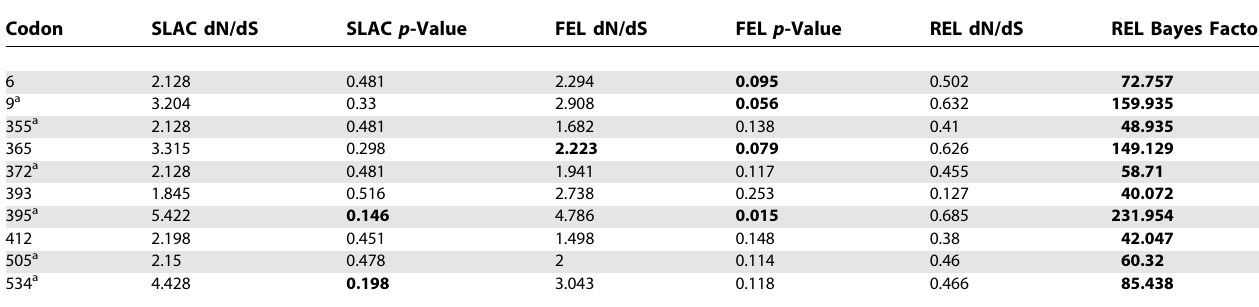
Table 2. Detection of Positive Selection Codon